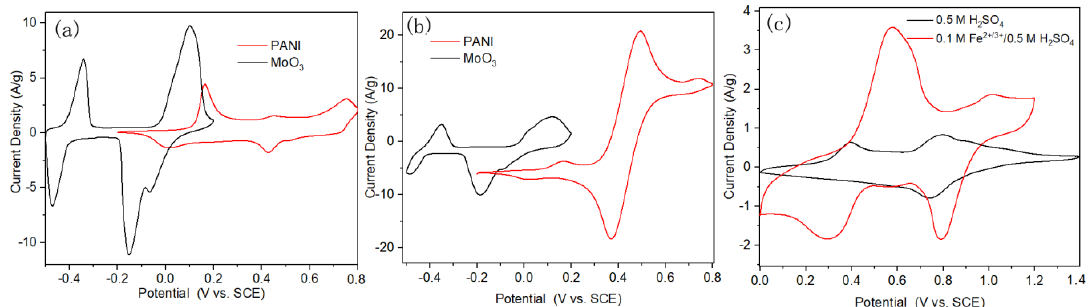
Figure 4. CV curves of PANI and MoO 3 electrode materials at a scan rate of 2 mV s − 1 in ( a ) 0.5 M H 2 SO 4 and ( b ) 0.1 M Fe 2+/3+ / 0.5 M H 2 SO 4 , respectively; and, ( c ) CV curves of asymmetric super-capacitors (ASCs) assembled with both PANI and MoO 3 electrodes at 5 mV s − 1 in different electrolytes.